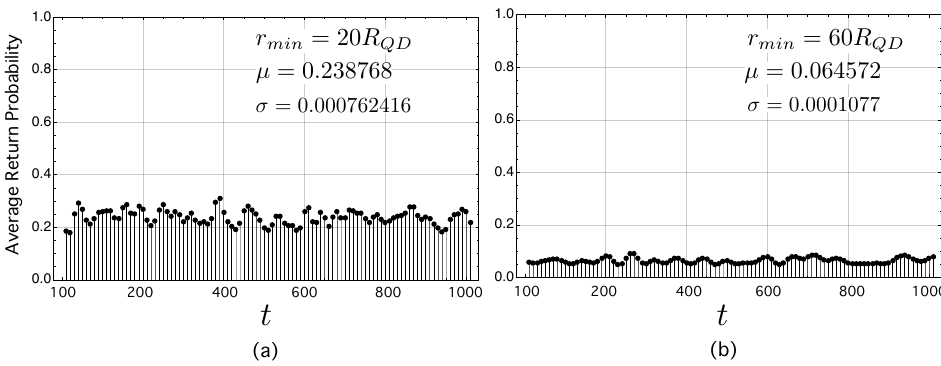
Figure 6. Average return probability (ARP) as a function of time (adimensional). As we have assumed ¯ h energy can be treated as dimensionless. Each value has been obtained as the mean value of the ARP over 50 networks with N = 100 nodes each. ( a ) ARP for an ensemble of networks with r min = 20 R QD . ( b ) ARP for an ensemble of networks with r min = 60 R QD